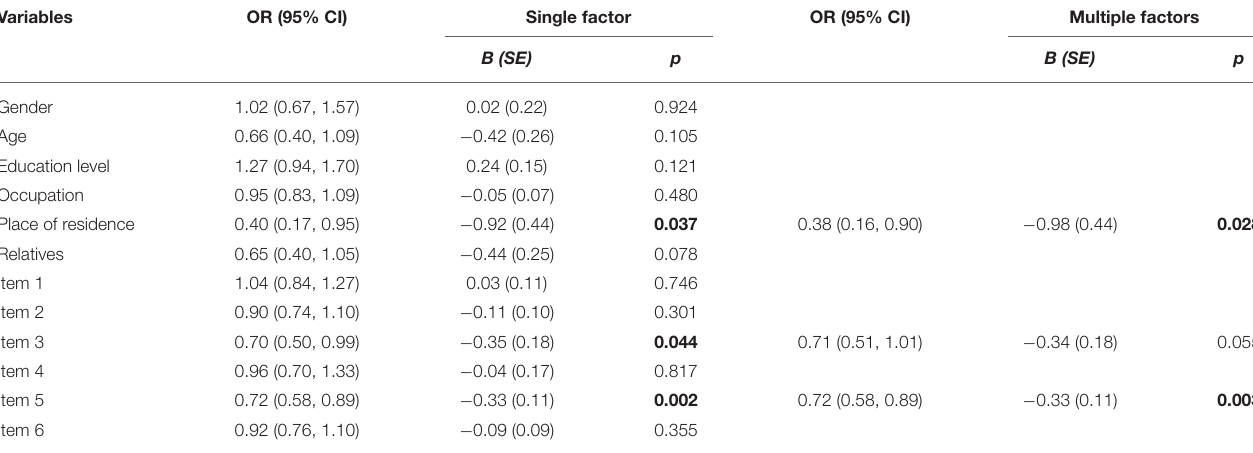
TABLE 4 | Logistic stepwise regression of perceptions and attitudes towards